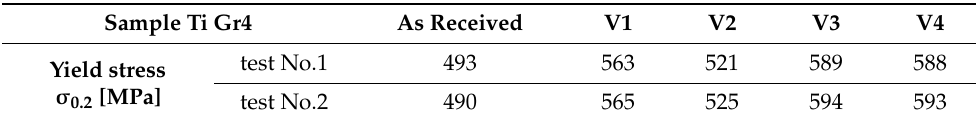
Table 9. Mechanical properties obtained for as-received Ti and processed Ti evaluated from the uniaxial compression tests.